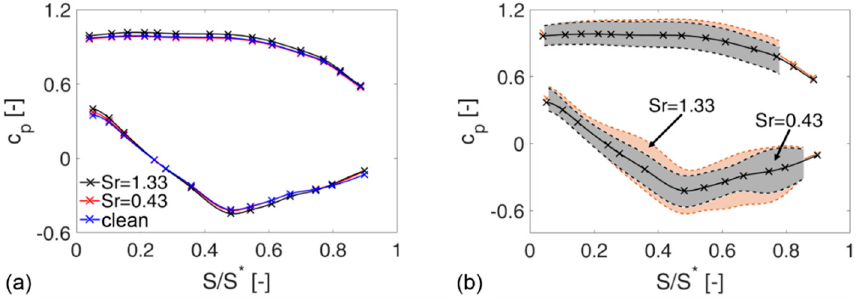
Figure 29. c p distributions for clean and perturbed inflow at T106 RUB midspan, time-averaged results ( a ), superposition of maximal fluctuation values ( b ), see [58].